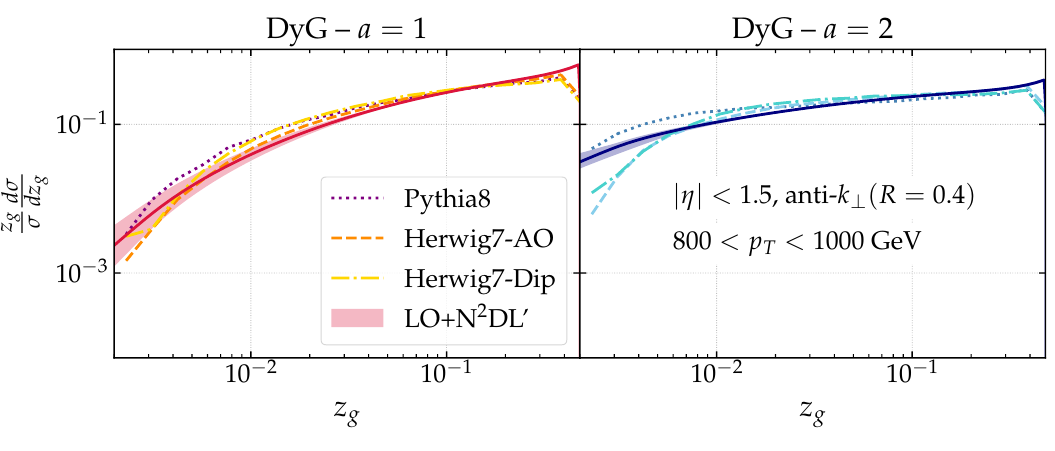
Figure 7 . Same as figure 6 but for z g